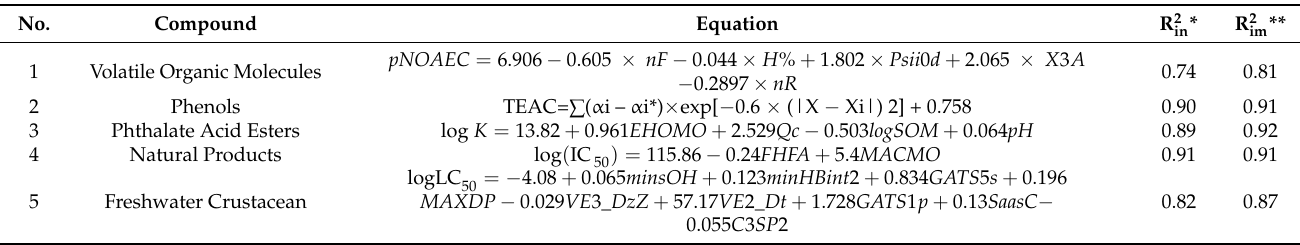
Table 4. Improved QSAR models for common toxicity prediction based on Table